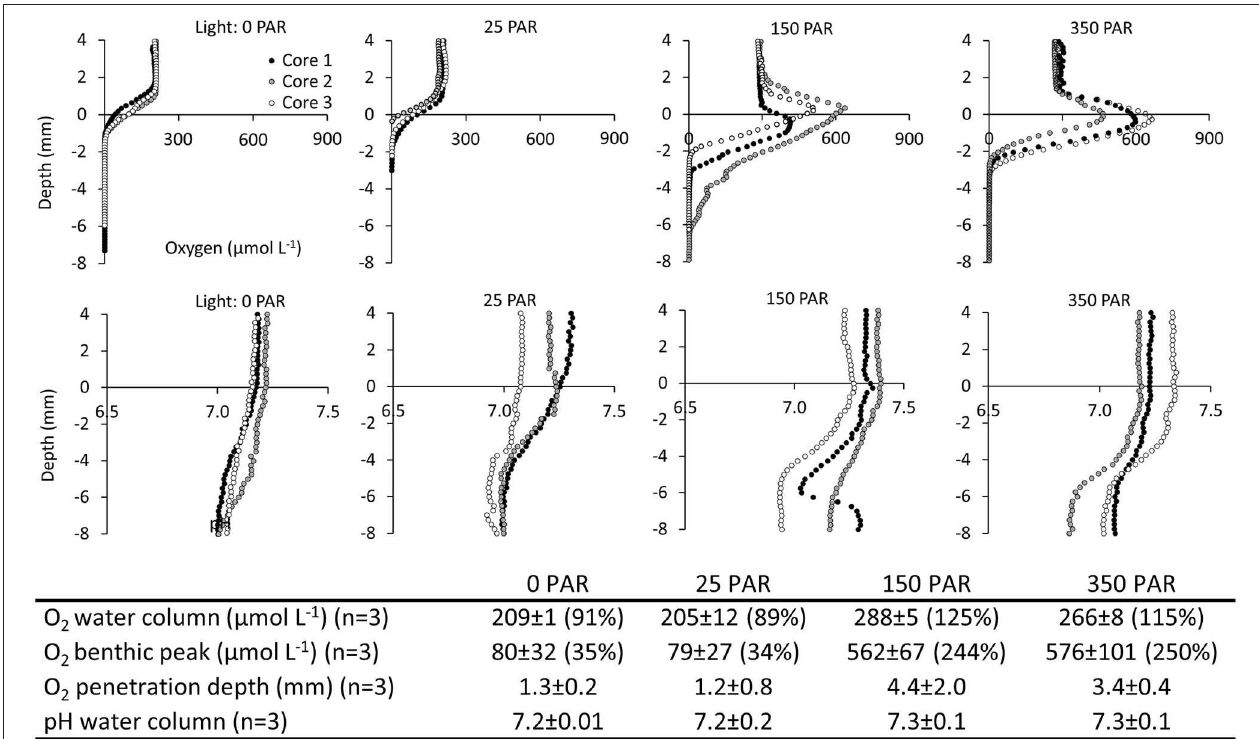
FIGURE 5 | Spatiotemporal variation of O 2 and pH in salt marsh ponds under different light regimes. Laboratory investigation. (Top panels) Vertical profiles of O 2 and pH at light intensities of 0, 25, 150, 350 µ mol photons m − 2 s − 1 photosynthetically active radiation (PAR). (Table inlet) Table of average O 2 and pH conditions at different light intensities. Percent (%) refers to % O 2 atmospheric